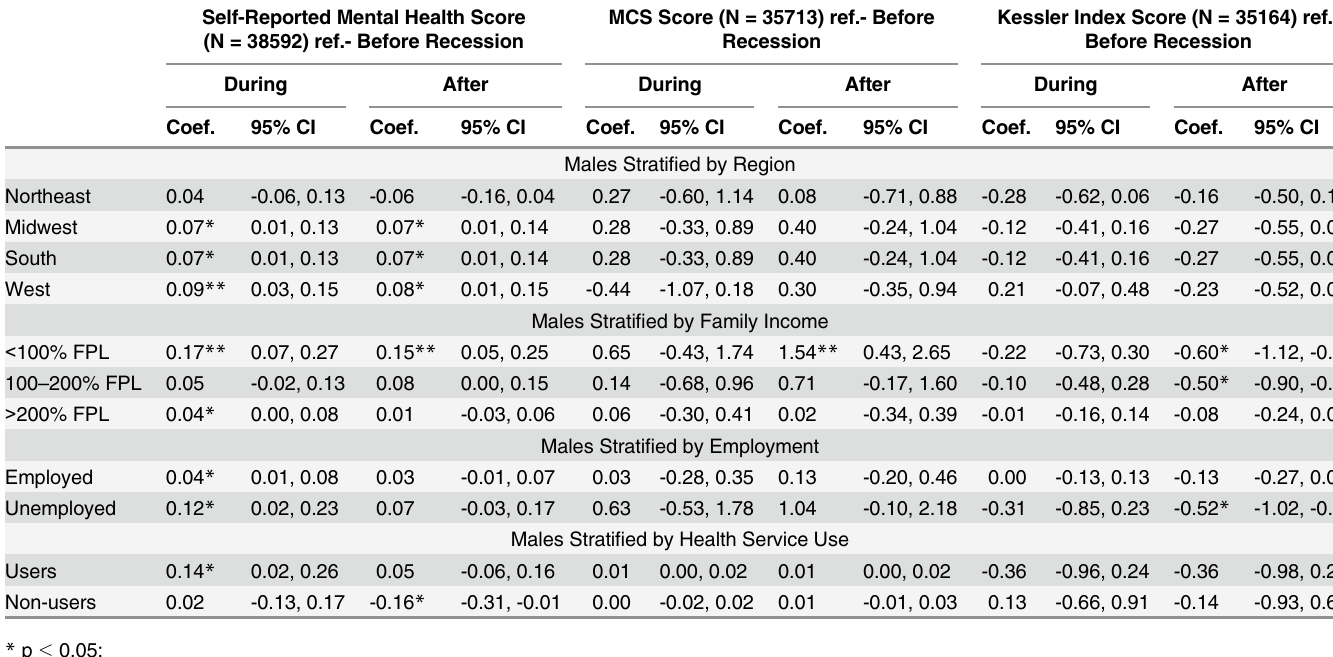
Table 7. Stratified multivariate analyses of recession indicators (during and after) and mental health indicators for males. Self-Reported Mental Health Score MCS Score (N = 35713) ref.- Before Kessler Index Score (N = 35164) ref.- (N = 38592) ref.- Before Recession Recession Before Recession During After During After During After Coef.